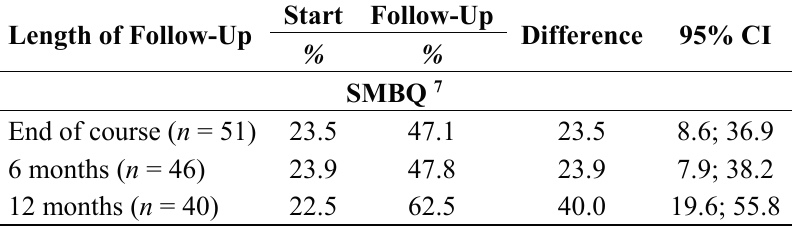
Table 2. Differences in paired proportions, with 95% confidence interval (CI) for participants scoring ˂ 4.4 on the SMBQ 7 . Comparing start of course with follow-up at course end, and six and twelve months,